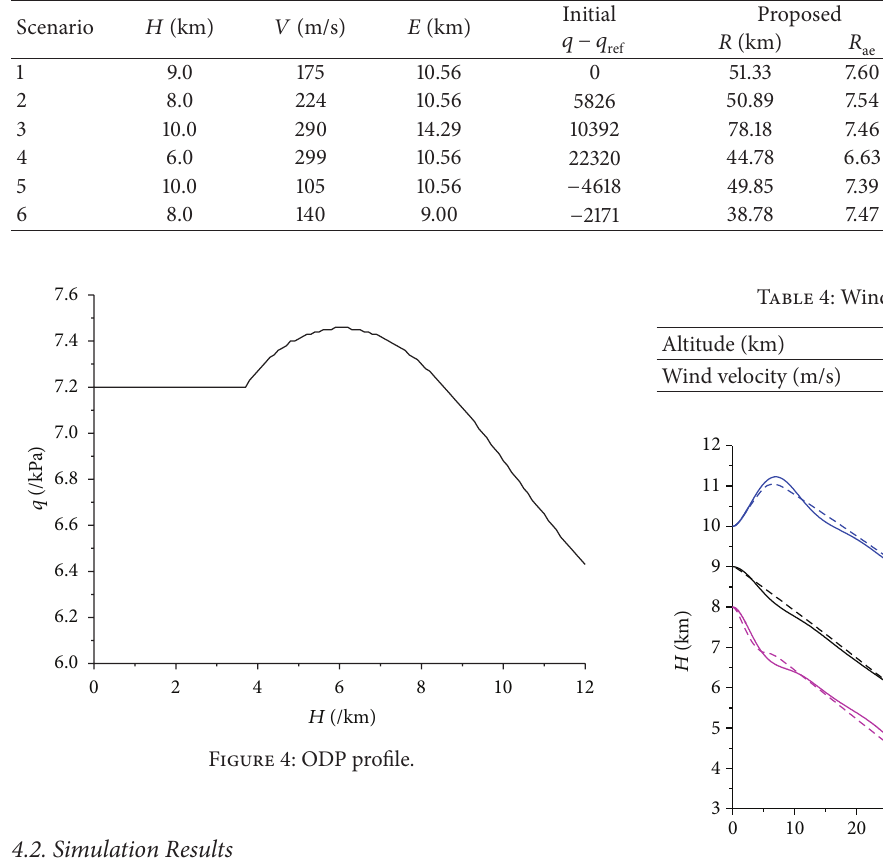
Table 3: Initial conditions and obtained maximum range using the proposed guidance scheme and optimal method.